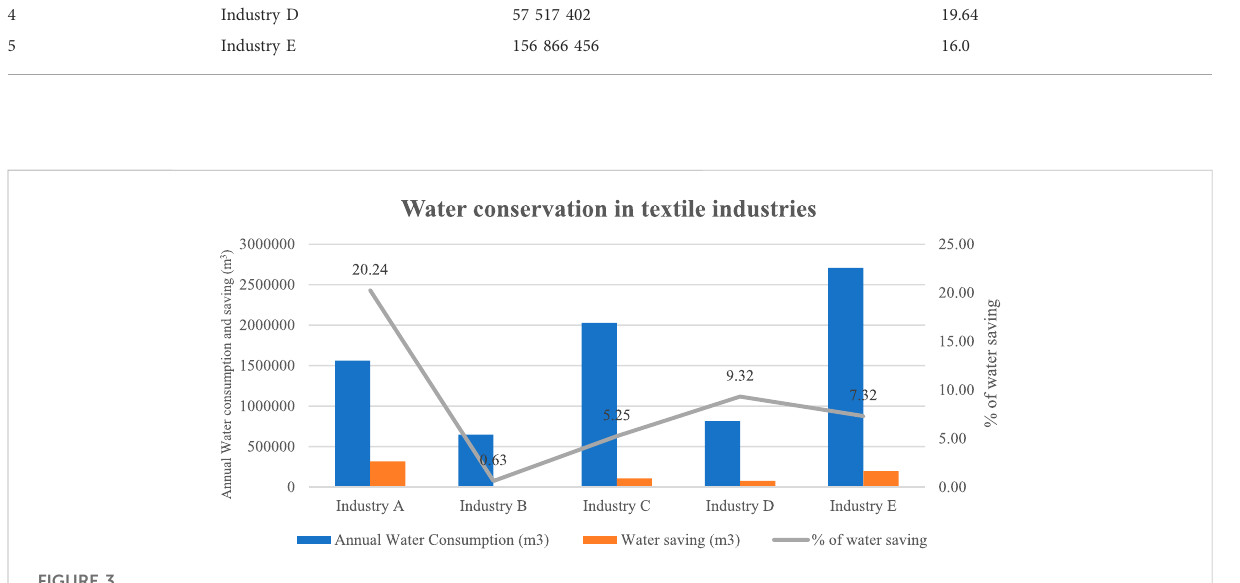
FIGURE 3 Comparison of volume fraction of water conservation (%) in textile industries.